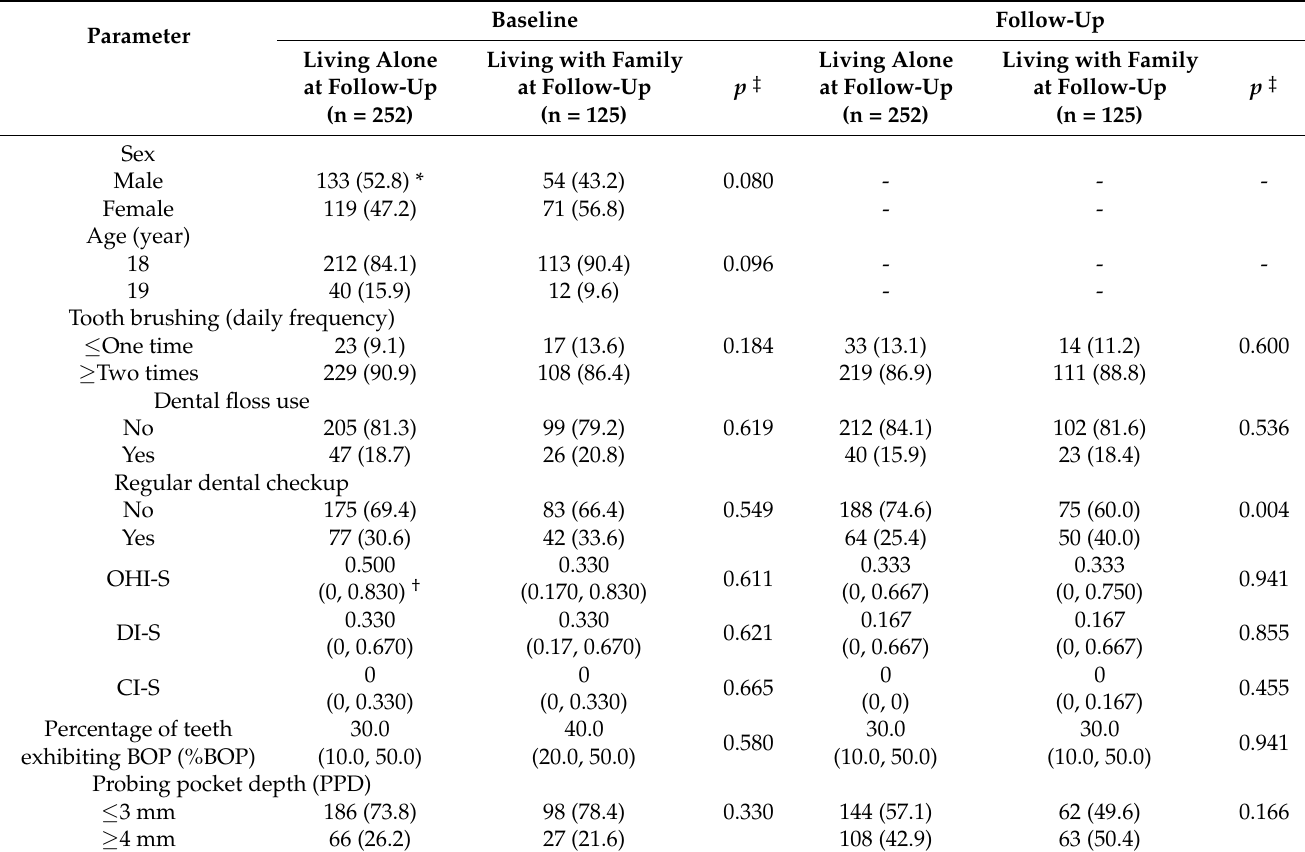
Table 2. Differences in sex, age, oral health behavior, and oral status by household type at baseline and follow-up.